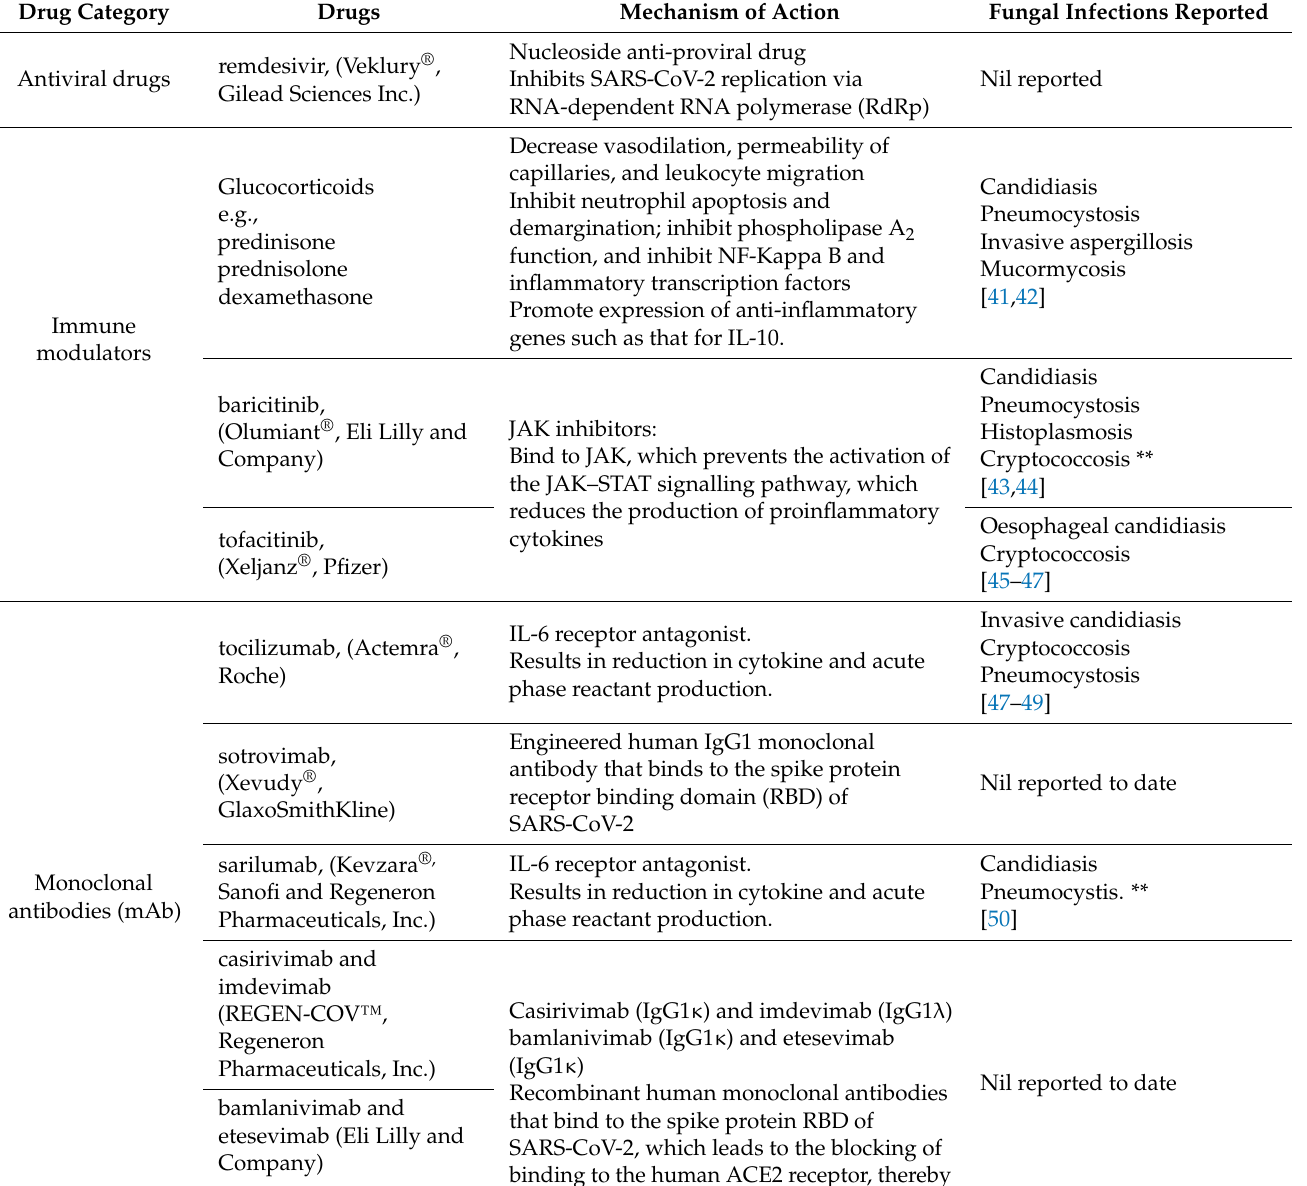
Table 1. Summary of therapies used for